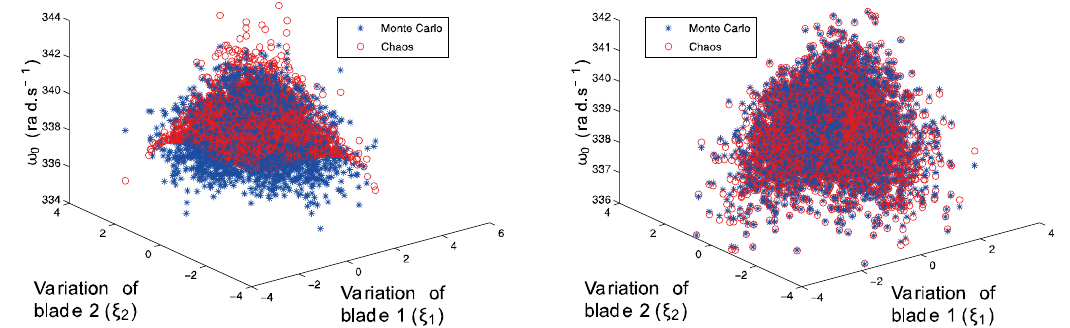
Fig. 4. Response surface of the eigenpulsations − Effect of the polynomial chaos order.